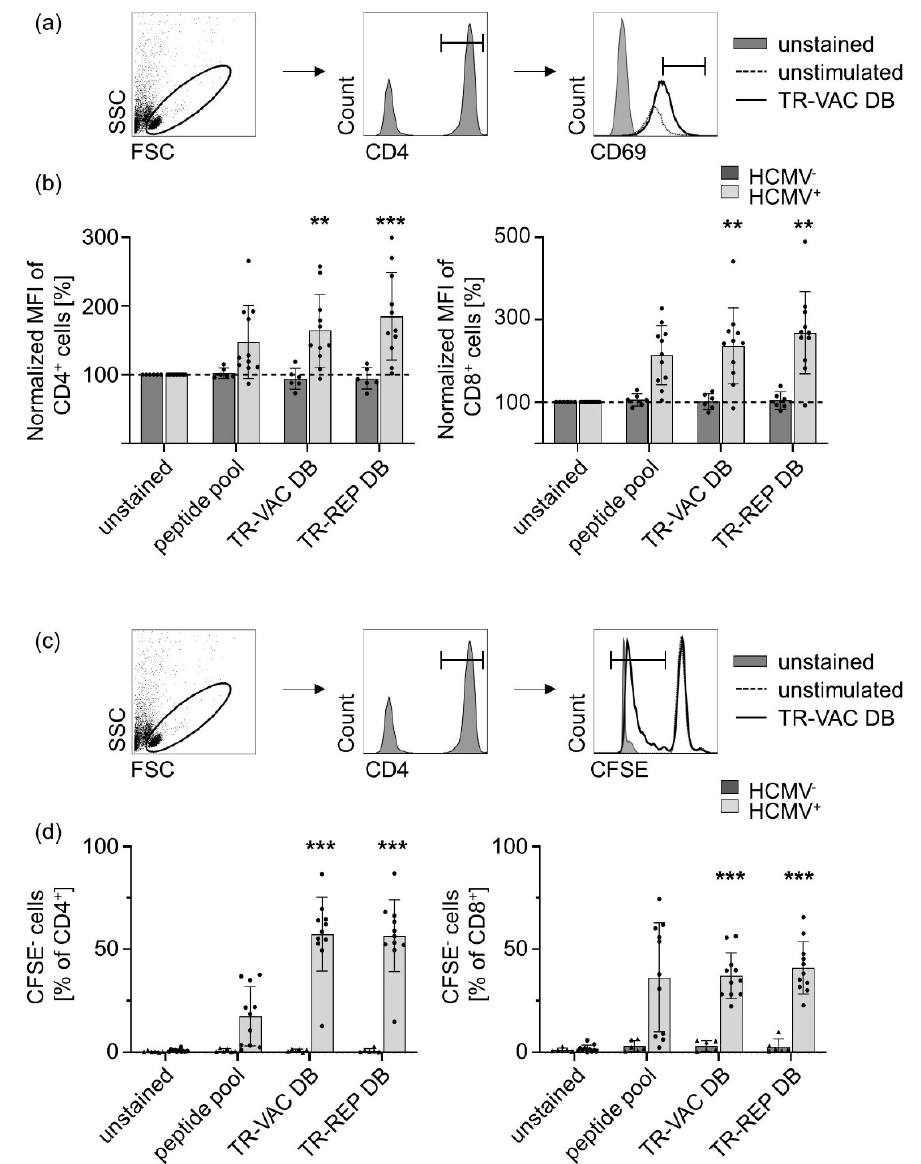
Figure 6. Co-cultivation of TR-VAC-stimulated human DC with HCMV-specific T cells. DC derived from HCMV- and HCMV+ donors were stimulated with TR-VAC DB or TowneUL130rep-ΔGFP (TR) DB (10 µg/5 × 10 5 DC), 0.4 µg/mL of a commercially available peptide pool as positive control, or were left untreated (Ø) for 24 h. Subsequently, CFSE-labelled autologous PAN T cells were added to treated DCs. After further incubation for 6 days, cells were harvested and stained with α -CD4-PE, α -CD8-PacificBlue, and α -CD69-APC-Cy7 antibodies for flow cytometric analyses. ( a ) Representative FACS-analyses of CD69 expression on CD4+ T cells for one HCMV+ donor is given comparing unstained (gray-shaded histogram), unstimulated (dashed line), and TR-VAC DB-stimulated (black line) cultures (peaks normalized to mode). ( b ) Statistical analyses of CD69 expression on CD4+ (left graph) and CD8+ (right graph) T cells of HCMV- (dark gray bars, n = 6) and HCMV+ (light gray bars, n = 11) donors. ( c ) Representative FACS-analyses of CFSE-dilution within CD4+ T cells for one HCMV+ donor is given comparing unstained (gray-shaded histogram), unstimulated (dashed line), and TR-VAC DB-stimulated (black line) cultures (peaks normalized to mode). ( d ) Statistical analysis of CFSE-dilution within CD4+ (left graph) and CD8+ (right graph) T cells of HCMV- (dark gray bars, n = 6) and HCMV+ (light gray bars, n = 11) donors. Statistical analysis was performed using Wilcoxon’s matched-pairs signed-rank test. **, p < 0.01 ***, p < 0.001; mean value plus